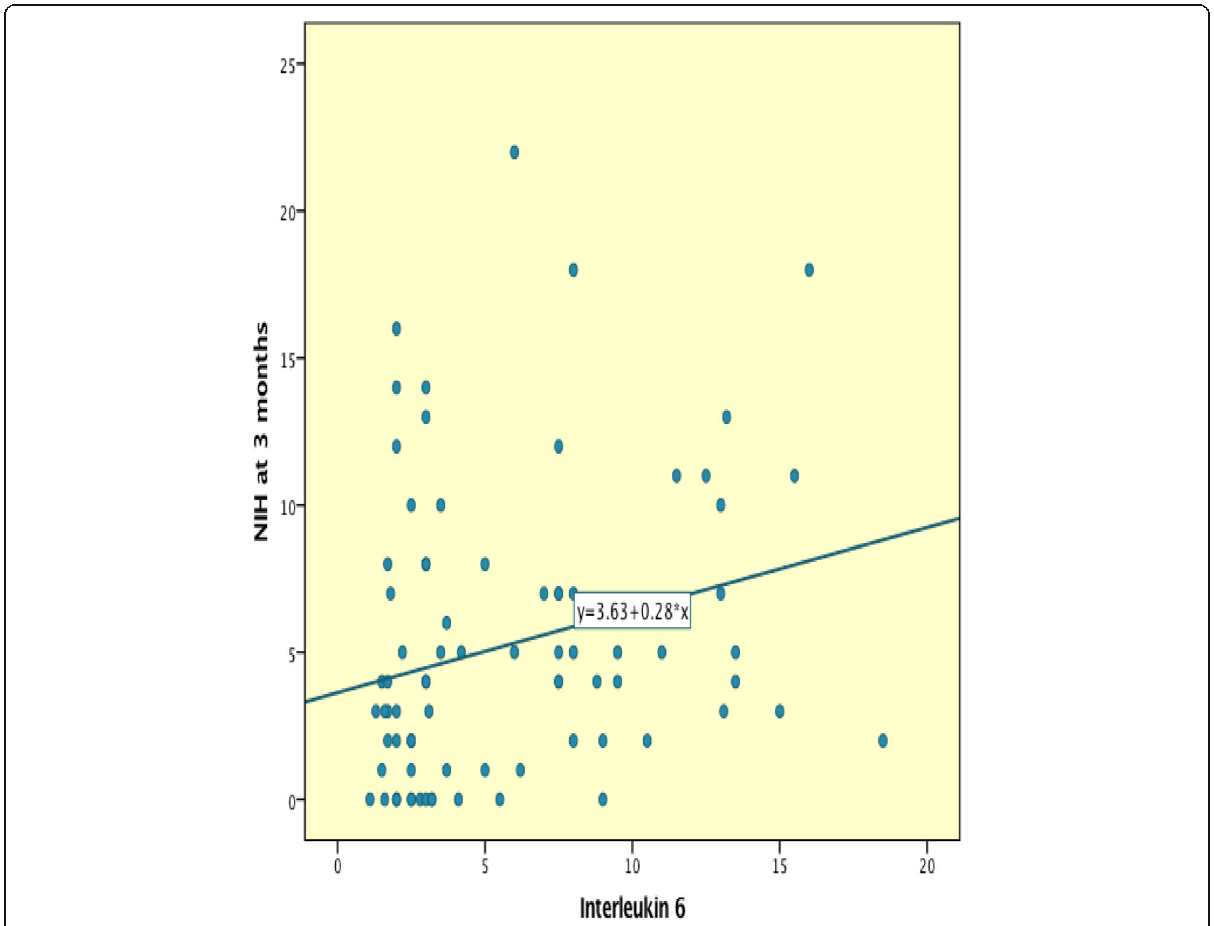
Fig. 1 Graphic representation of the correlation between NIHSS after3 months and IL-6. There was significant positive correlation between IL-6 and NIHSS after 3 months ( P = 0.009) ( r =